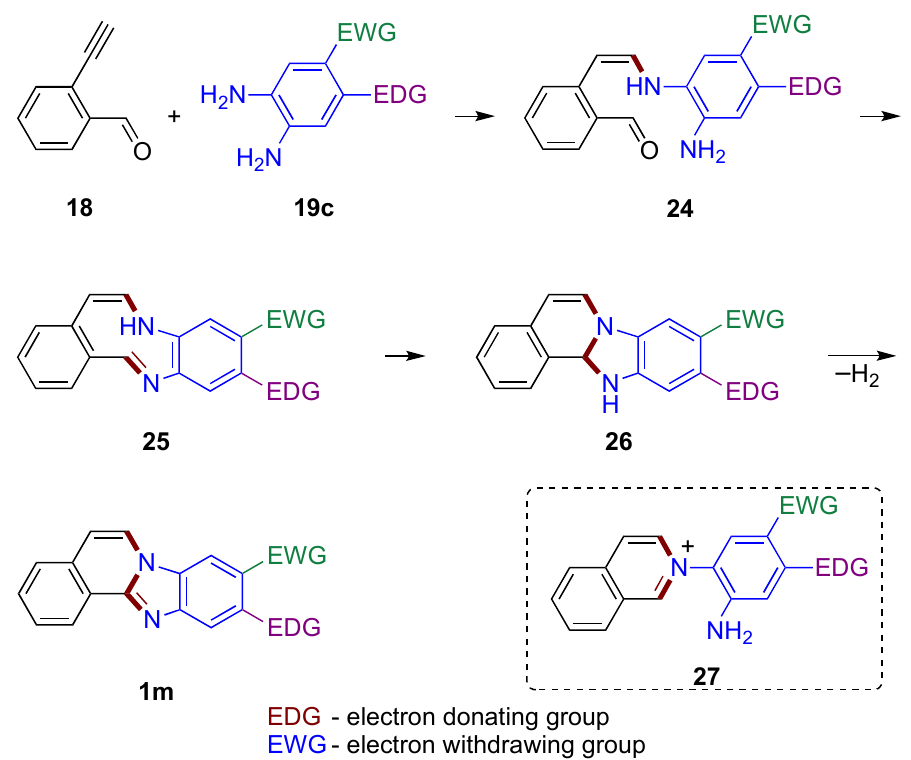
Figure 19. Mechanistic outline illustrating one of the amino groups of o -phenylenediamine reacting with the alkyne first.